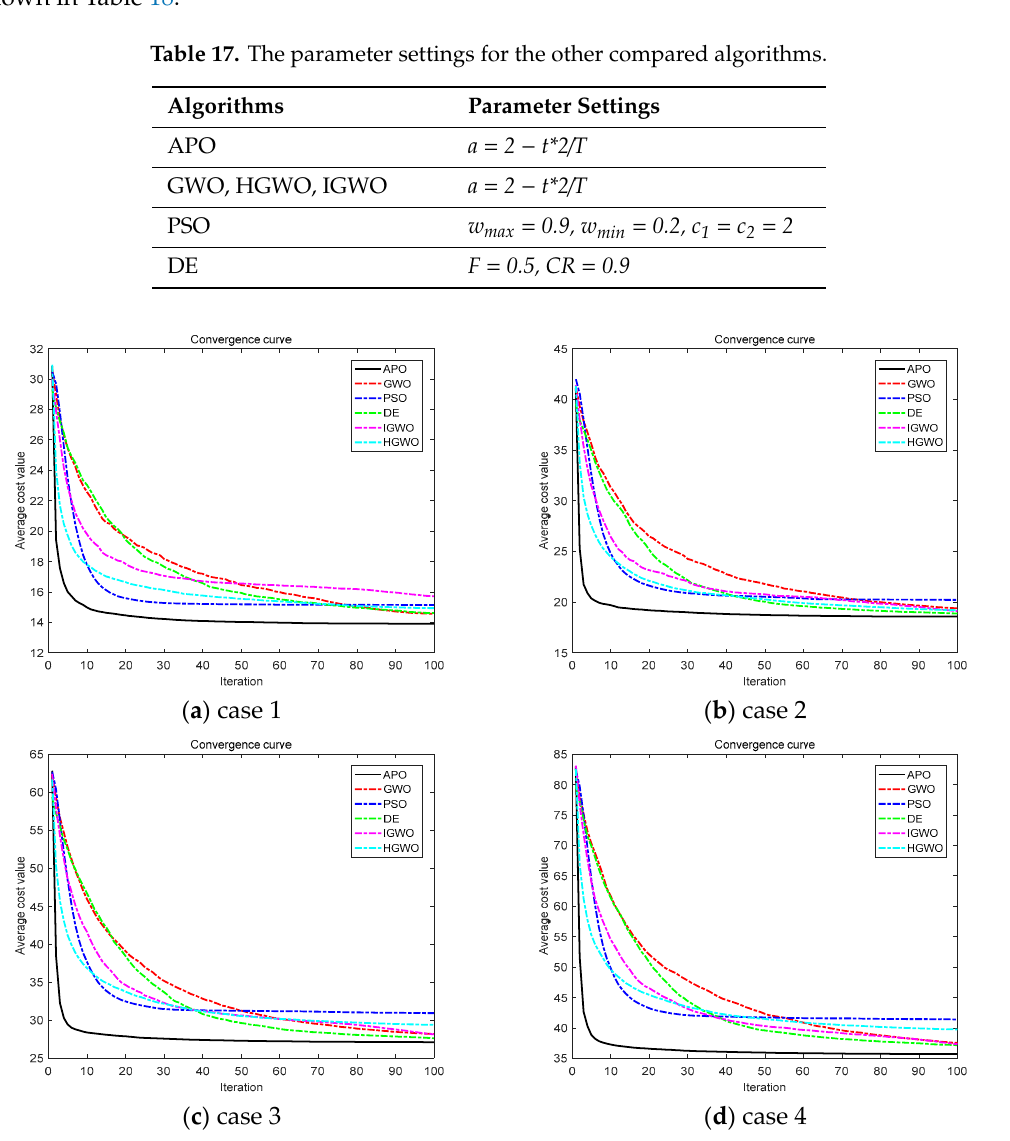
Figure 12. The convergence curve of the 3D-integrated path cost of each case. ( a ) case 1; ( b ) case 2; ( c )case 3; ( d )case 4. Table 18. The average time of each algorithm in each case (unit: s).